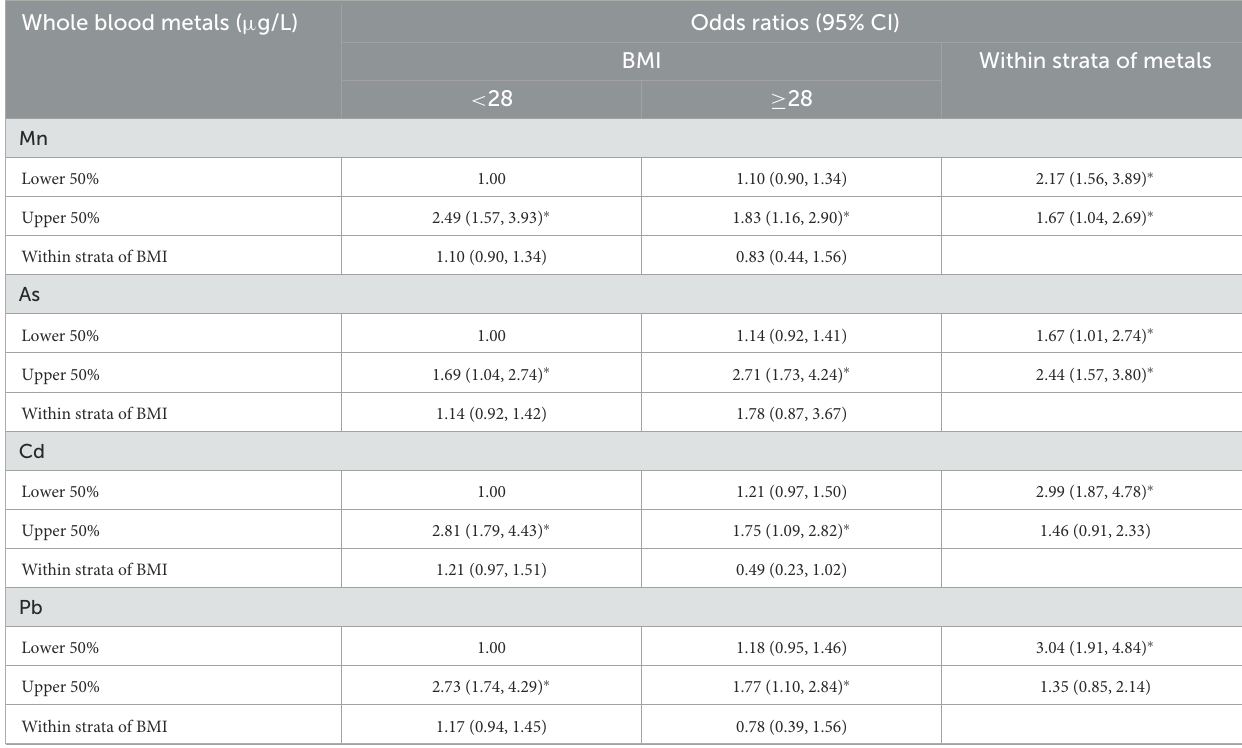
TABLE 4 Effect of interaction between whole blood metal and BMI on hypertension risk. Whole blood metals ( µ g/L) Odds ratios (95% CI)